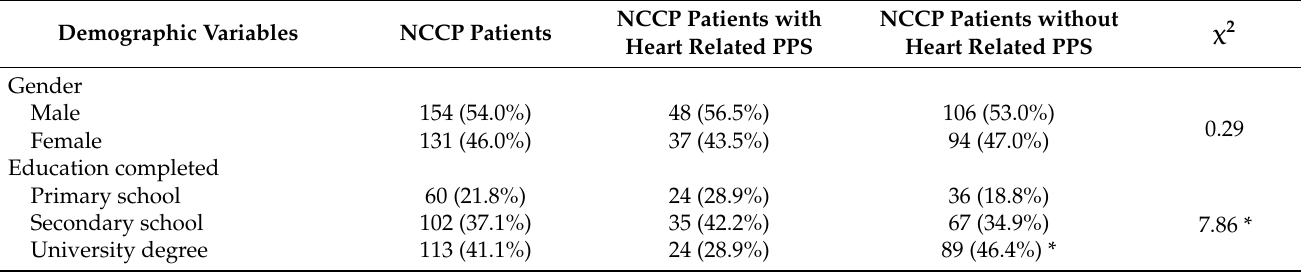
Table 1. Gender, education and relationship status of NCCP